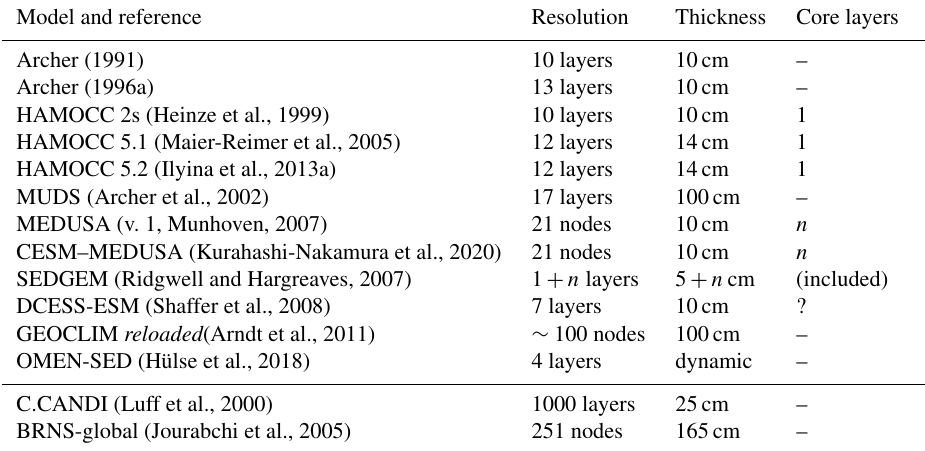
Table 1. General characteristics of vertically resolved sediment models used in global biogeochemical models and, for comparison, of two high-complexity models (C.CANDI and BRNS-global). The numbers of layers or nodes were taken from the respective papers and are only relevant for components whose concentration profiles are spatially resolved and not for those that are supposed to be well mixed (see Table 2). “ n layers” means that the number of layers is not fixed but grows as simulations proceed. For GEOCLIM reloaded , the number of layers was estimated from the given thicknesses of the topmost and the bottommost layers as well as the reported grid-point distribution function. OMEN-SED has four functional biogeochemical layers based upon redox zonation; their thicknesses adjust on the oceanic boundary